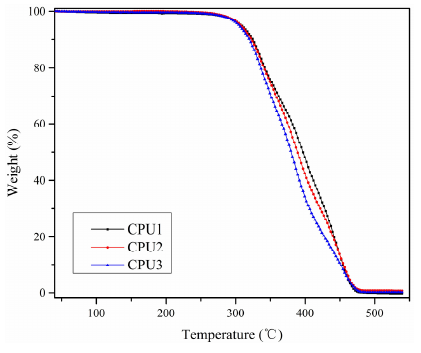
Figure 4. TGA curves of different CPUs.